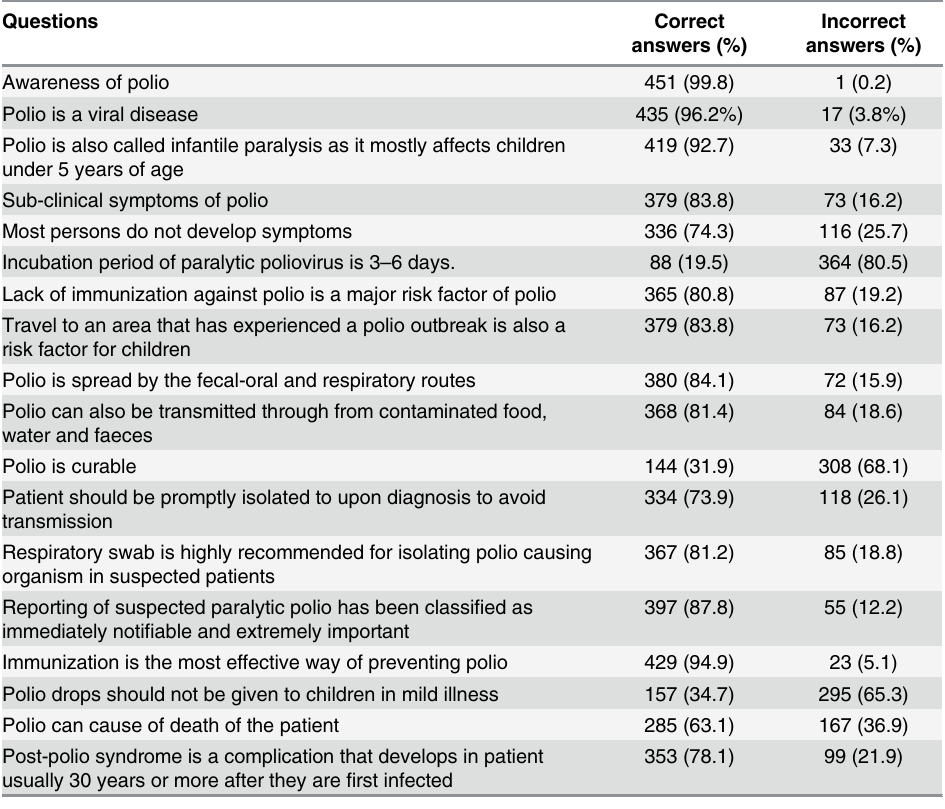
Table 2. Knowledge of participants towards